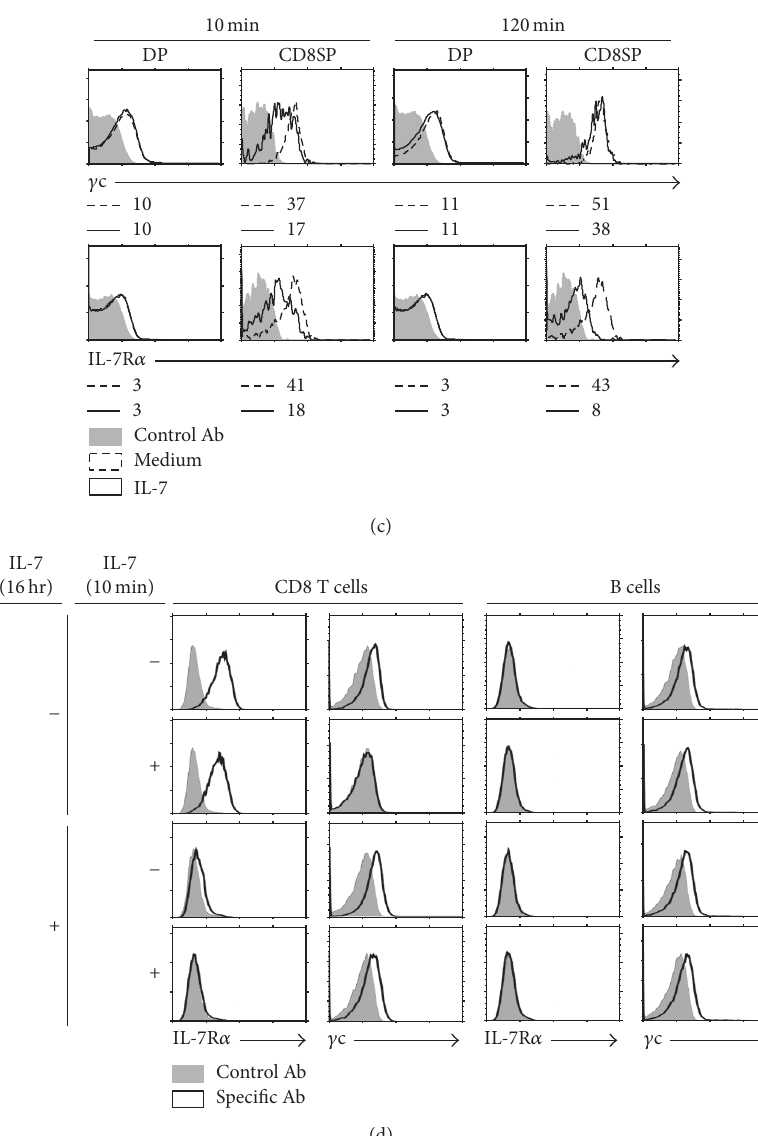
Figure 2: IL-7 specific and IL-7R 𝛼 dependent reduction of 𝛾 c surface expression. (a) T cells were stimulated with 𝛾 c cytokines (IL-2, IL-4, IL-7, IL-9, IL-15, and IL-21) or representative non- 𝛾 c cytokine (IL-6) as negative control for 10 or 120 minutes, and the 𝛾 c (4G3) expression was analyzed by FACS. The relative 𝛾 c expression was calculated as the Δ MFI associated with the cytokine-treated group over the Δ MFI associated with the medium control group. Data are summary of more than three independent experiments (mean and SEM). (b) LN cells were stimulated in the presence or absence of IL-7, and the cytokine receptor expression was analyzed by FACS at the indicated time points. The maximum value of 𝑥 -axis is 250 for 10-minute to 4-hour histograms and is 200 for 16-hour histogram. Histograms are representative of five independent experiments. (c) Thymocytes were stimulated in the presence or absence of IL-7, and the 𝛾 c (4G3) expression was analyzed 10 and 120 minutes after stimulation by FACS. The cells were gated on CD4 + CD8 + and CD4 − CD8 + thymocytes, and the 𝛾 c (4G3) and IL-7R 𝛼 expression in IL-7 treated cells were compared with IL-7 nontreated thymocytes. The maximum value of 𝑥 -axis is 500 for DP histograms and is 15 for CD8SP histogram. Histograms are representative of three independent experiments. (d) T cells were incubated in the presence or absence of IL-7 for 16 hours, and culture media were changed to fresh media or IL-7 media, and the 𝛾 c (4G3) expression was analyzed 10 minutes after the media change. The maximum value of 𝑥 -axis is 150 for medium histograms and is 250 for IL-7 pretreated histogram. Histograms are representative of three independent